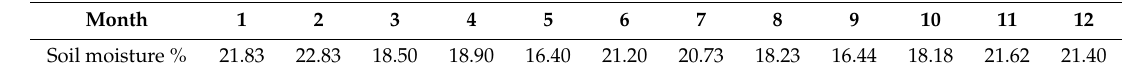
Table 7. Soil Moisture of Each Month in 2013.